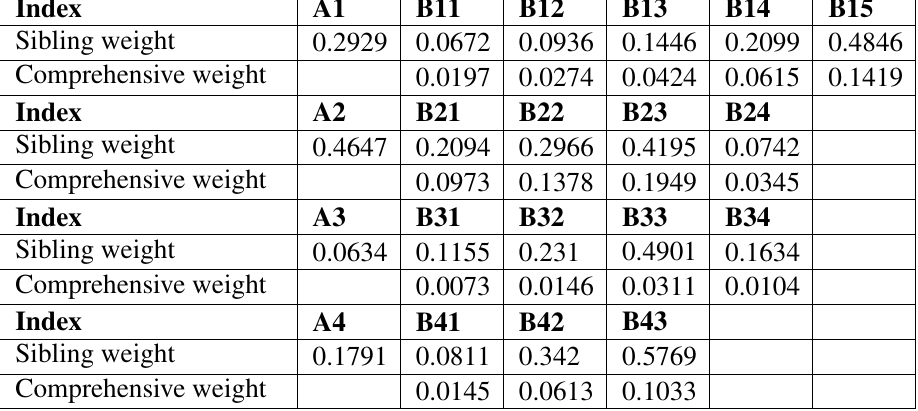
Table 5 Analytic hierarchy process to determine the weight distribution of indicators